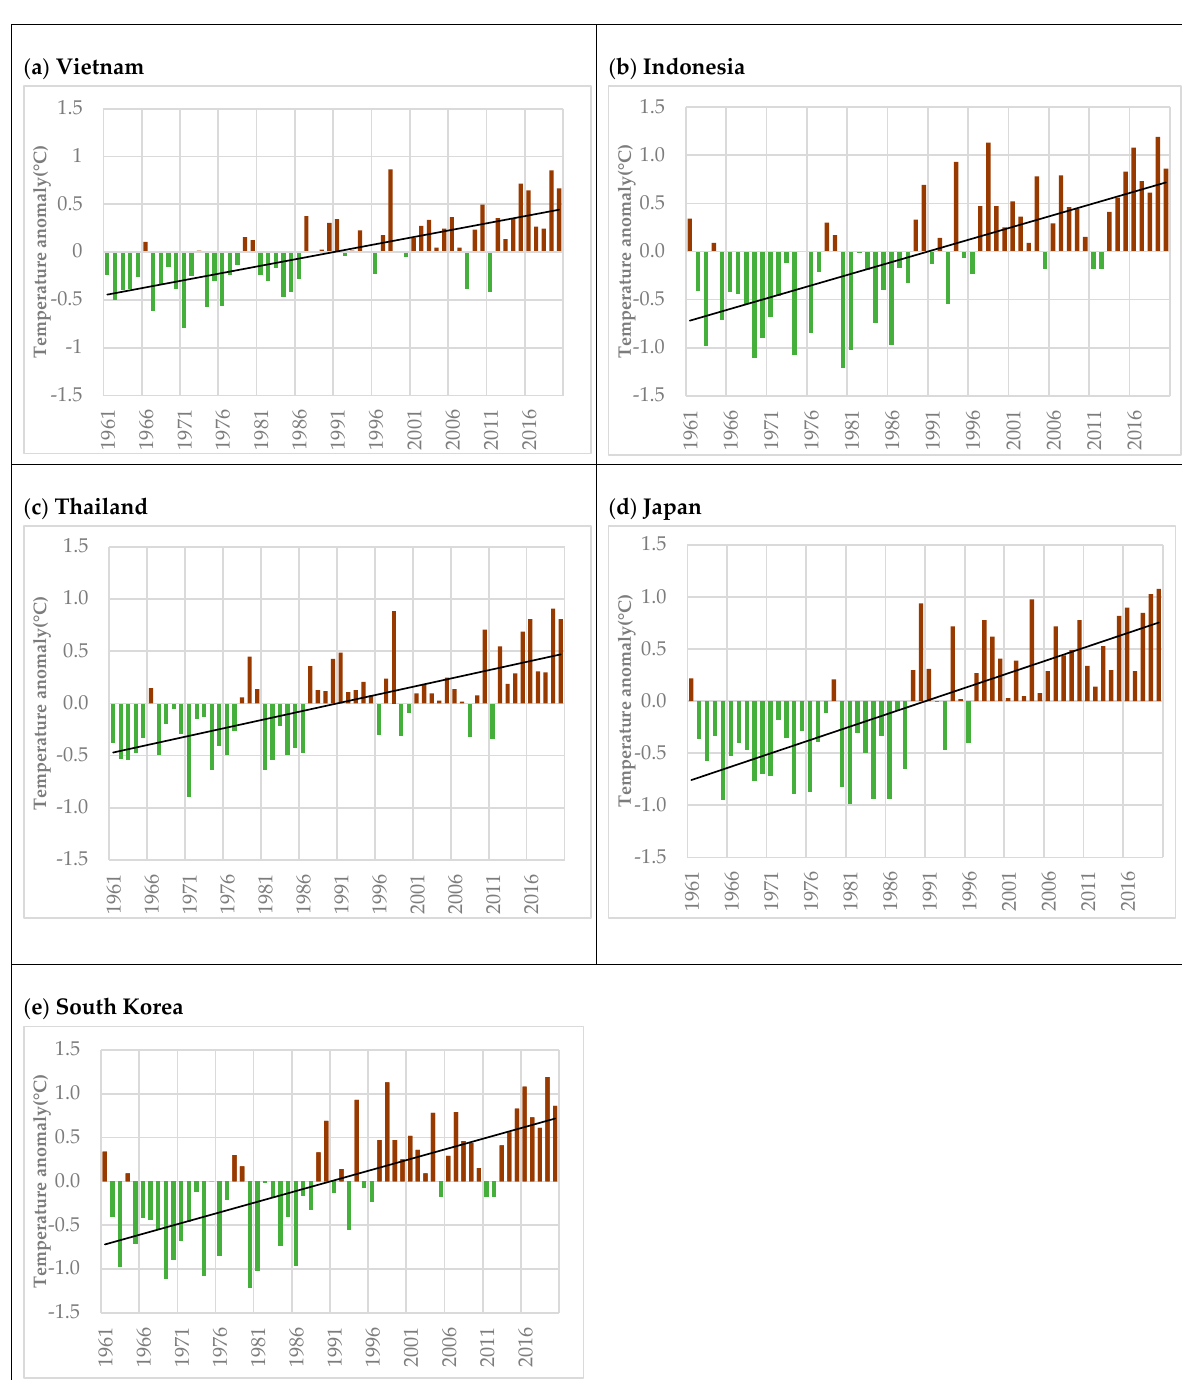
Figure 13. Average annual mean temperature anomalies in ( a ) Vietnam, ( b ) Indonesia, ( c ) Thai- land, ( d ) Japan, and ( e ) South Korea. These data range from 1961 to 2020. (Source: data retrieved from